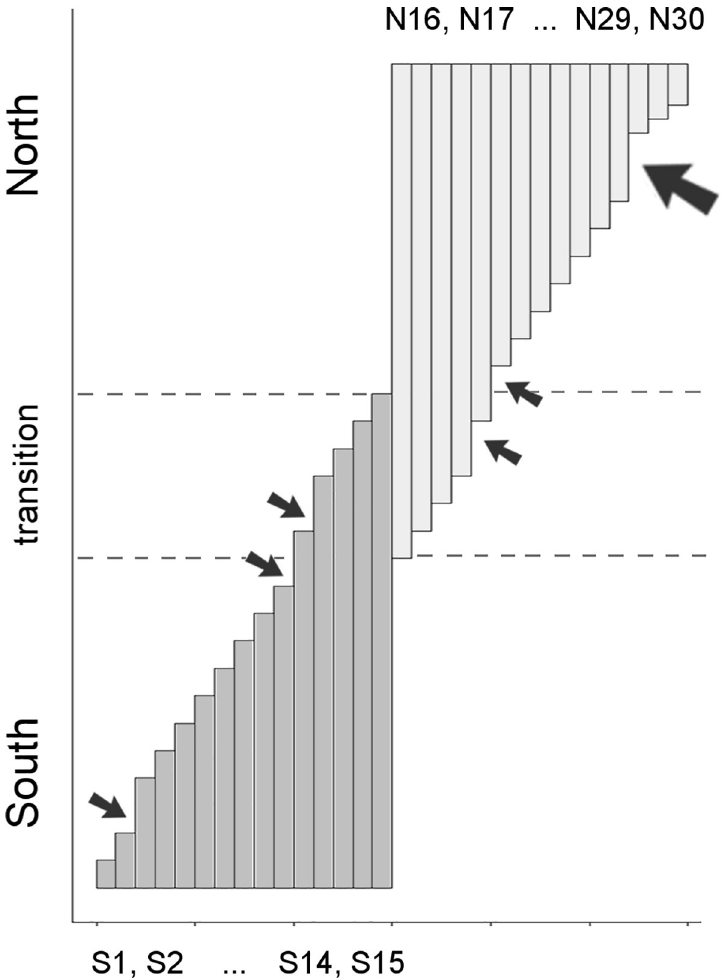
Fig 2. Schematic representation of the hypothetical gradient of thirty species ranges proposed by Kreft & Jetz [45]. Two well delimited biogeographical centers of diversity, a northern (pale gray) and a southern (medium gray), have species extending their ranges through a zone of transition. Each vertical bar represents the latitudinal extent of the range of a particular species (named S1-15 and N16-30). The longitudinal ranges (bar widths and position) of all species are assumed to be identical, such that they all overlap spatially. The original symmetric scheme [45] included a few small exceptions (small arrows) to the otherwise uniformly graded range differences. To further examine the influence of non-uniform gradations on detection of congruence patterns, we reduced the range differences among N28-30 relative to the others, which adds a single slightly larger range discontinuity (large arrow).